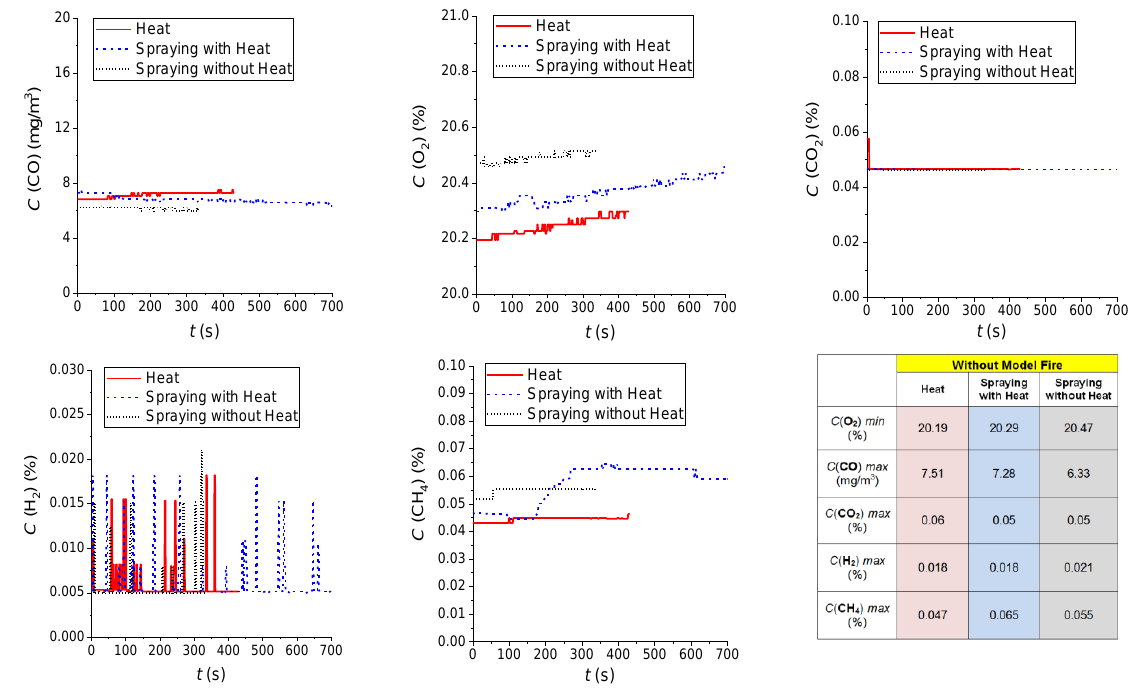
Figure 14. Trends of O 2 , CO, CO 2 , H 2 and CH 4 concentrations: 1–hot plate heating without aerosol spray; 2–spraying aerosol on the heated surface; 3–spraying aerosol with no